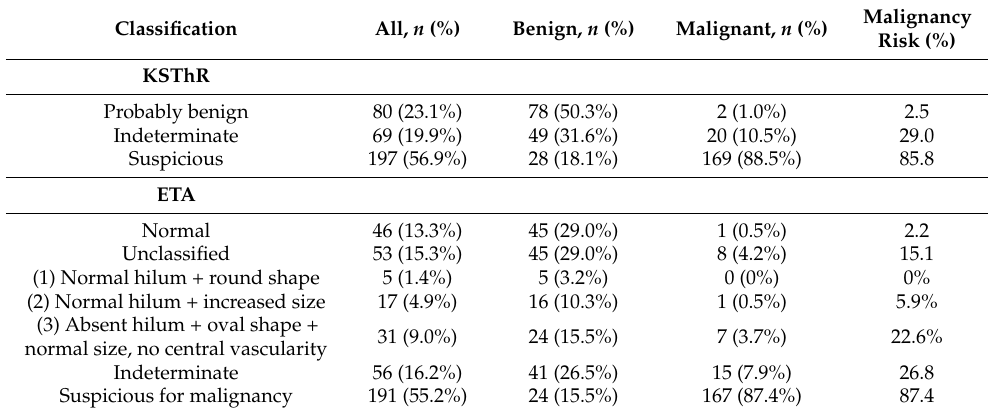
Table 3. Demographic and clinical characteristics of patients and lymph nodes